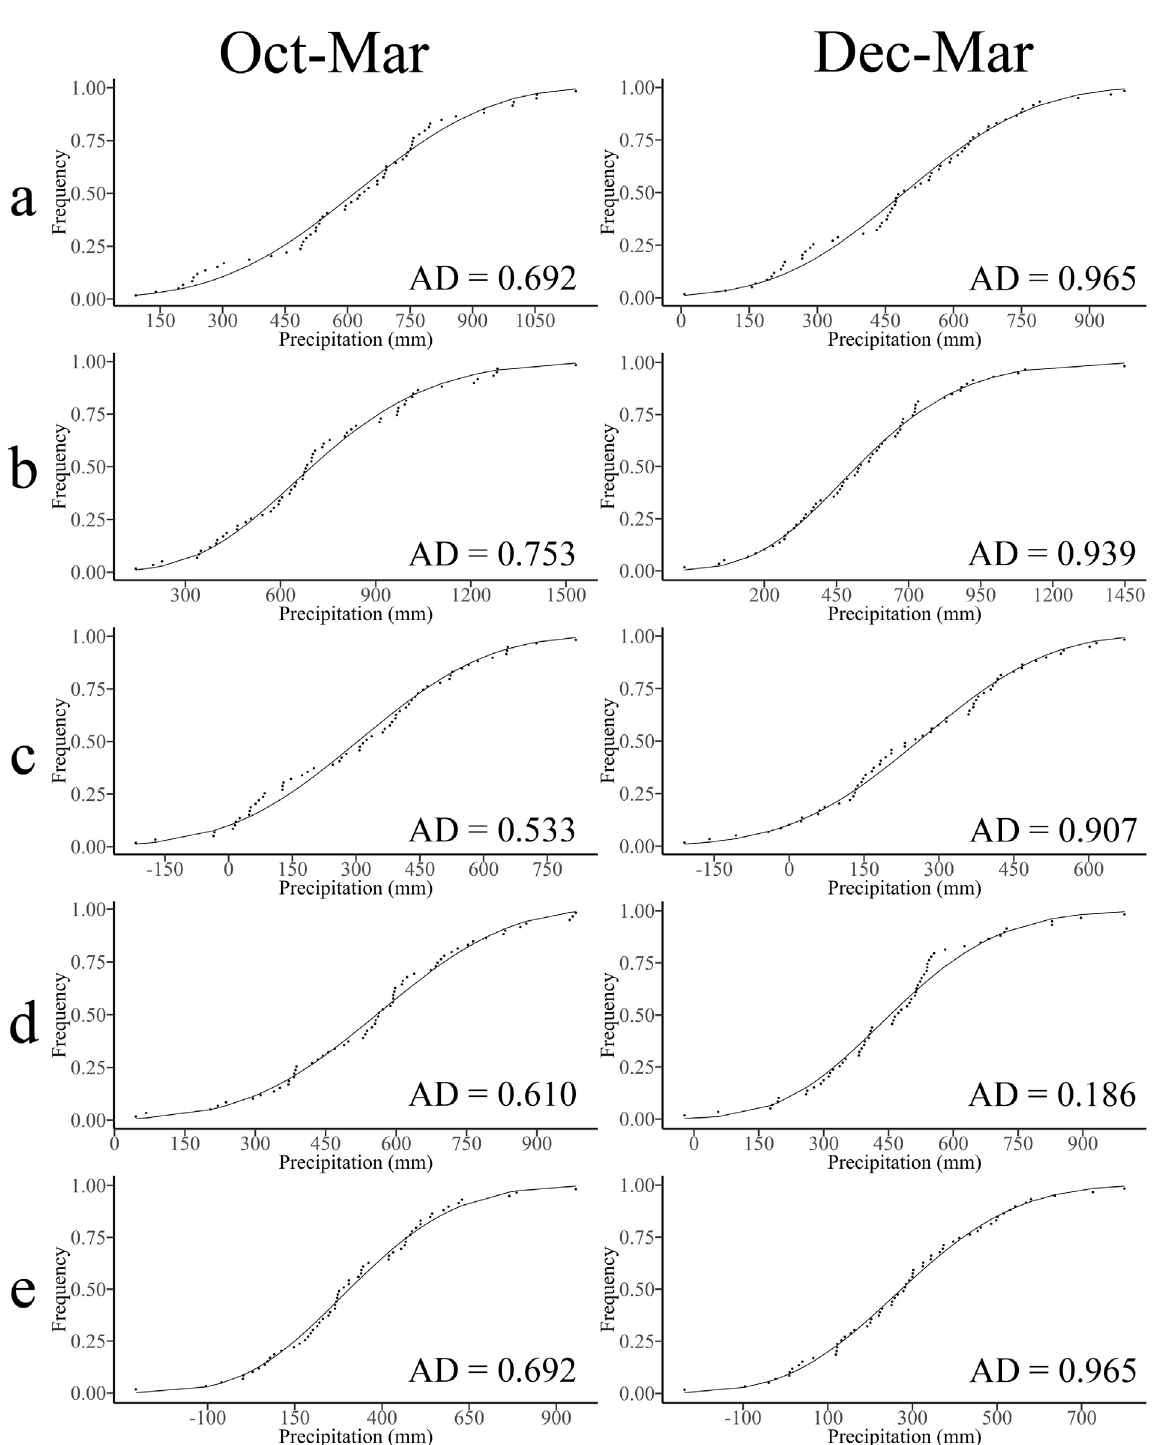
Figure 4. Goodness of the fit of the GEV PDF to P – ETp historical series for the studied locations of southeastern Brazil tested by the Anderson-Darling test (a. South-MG; b. MR-BH; c. ME-SP; d. SP; e.